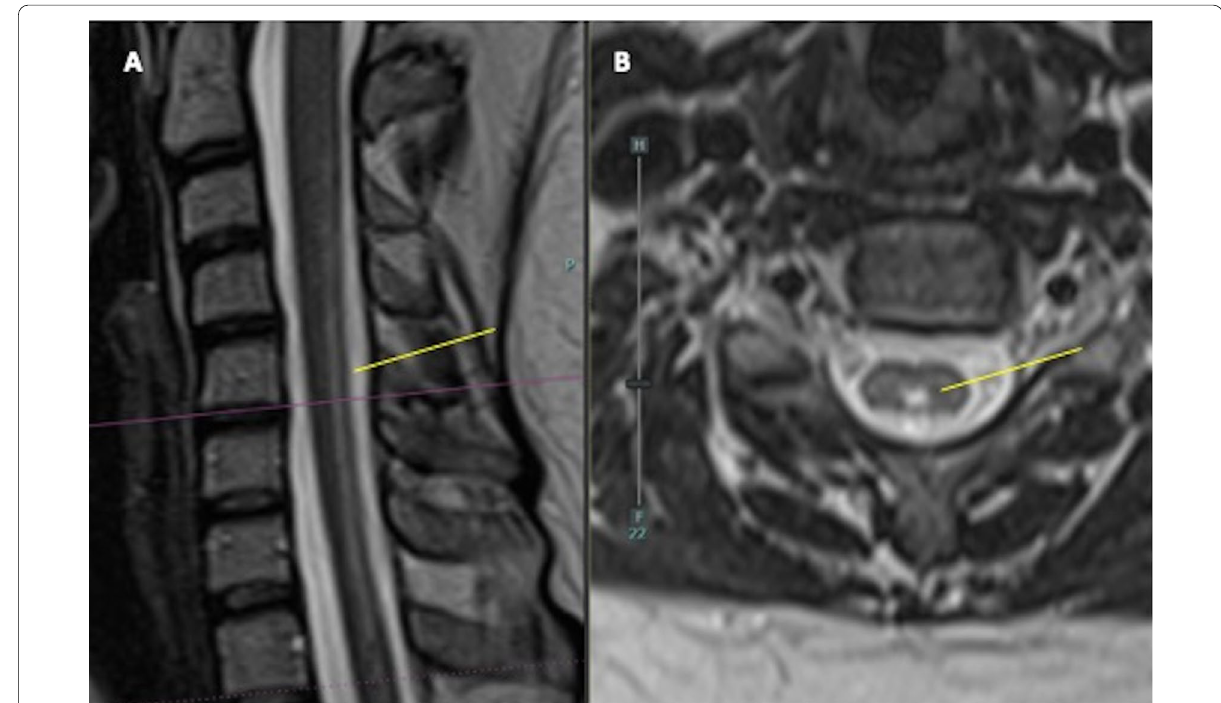
Fig. 2 MRI sagittal T2 image ( A ) of the cervical spine demonstrates longitudinally extensive T2 hyperintense cord lesions (yellow arrow), with corresponding foci that are as bright or brighter than CSF on the axial images ( B ) (yellow arrow)